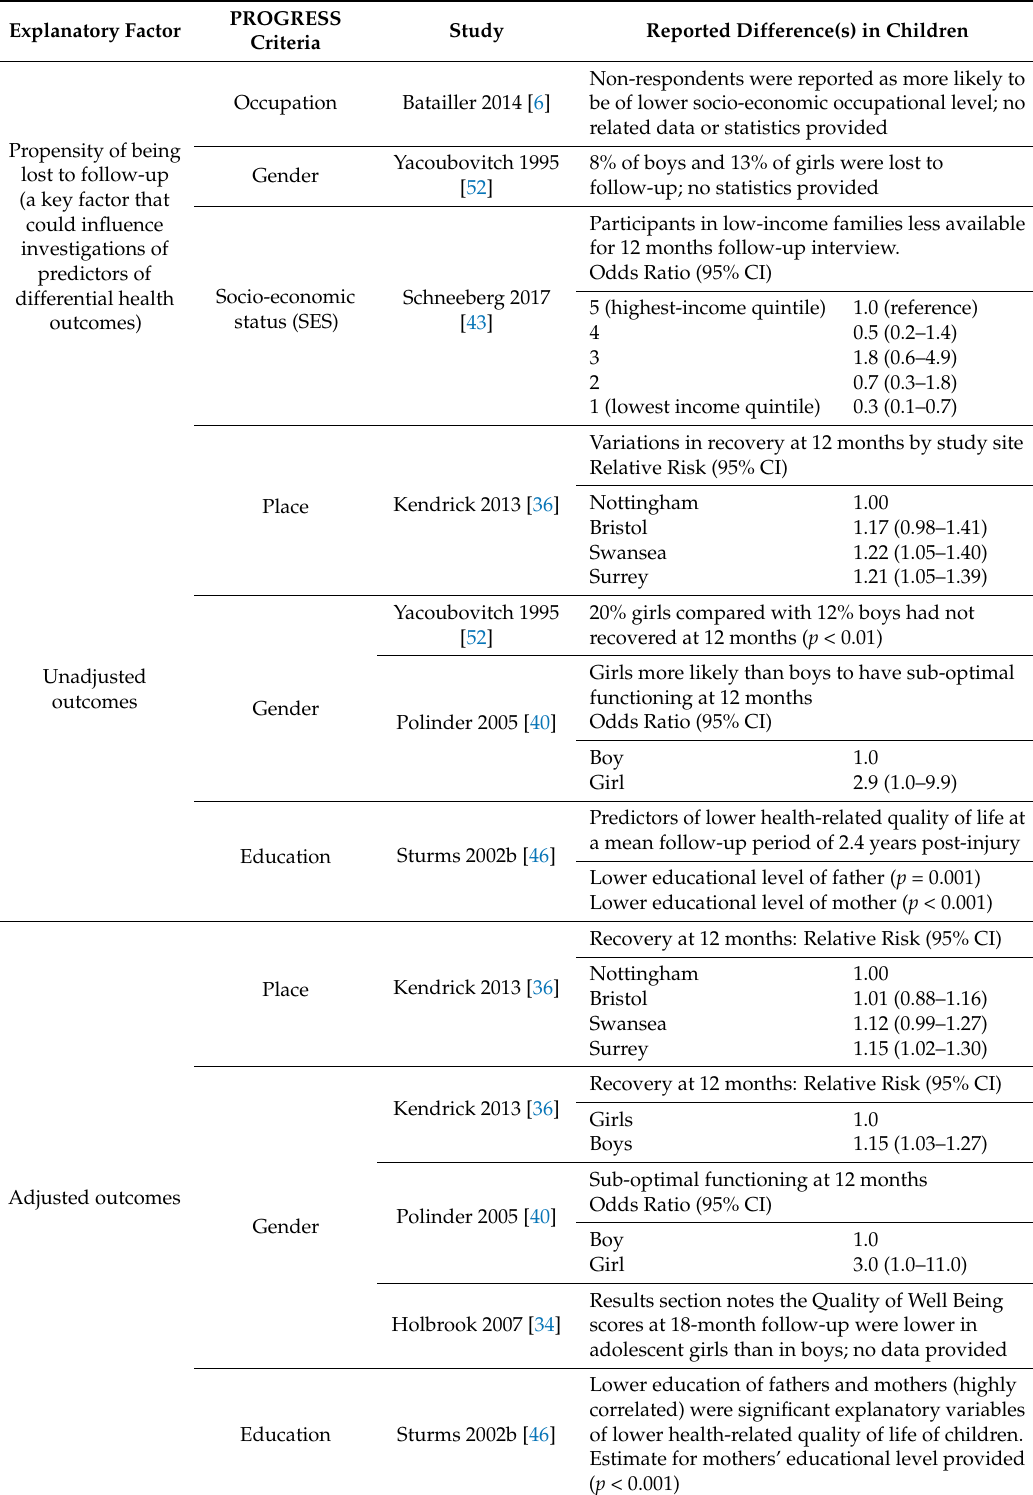
Table 4. General trauma follow-up studies in childhood identifying influences on, or significant variations in, health outcomes by PROGRESS